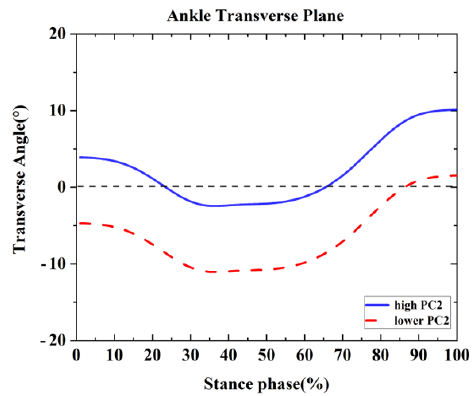
Figure 4. Principal components are retained for the ankle. The waveform differences between competitive runners and recreational runners of reconstruction principal using the high and lower PC2-scores in the ankle transverse plane.